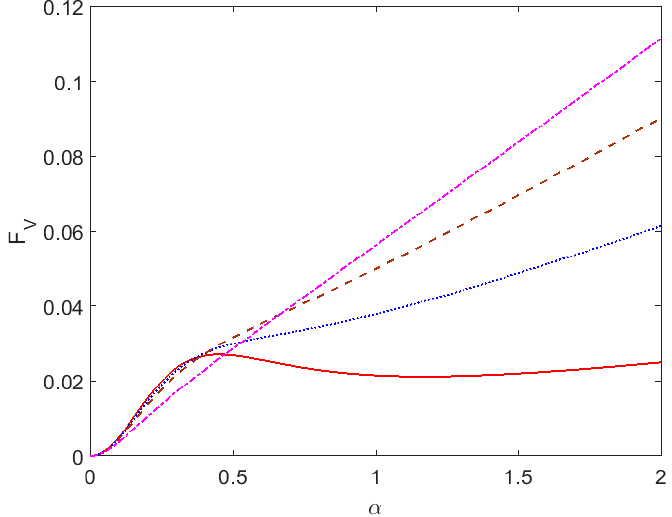
Figure 3. Dependence of Voigt function F V upon dimensionless pulse duration for dimensionless detuning δ = 3 and different values of ratio ρ = γ / ∆ : solid line − ρ = 0.1, dotted line − ρ = 0.5, dashed line − ρ = 1, dotted–dashed line − ρ = 3.